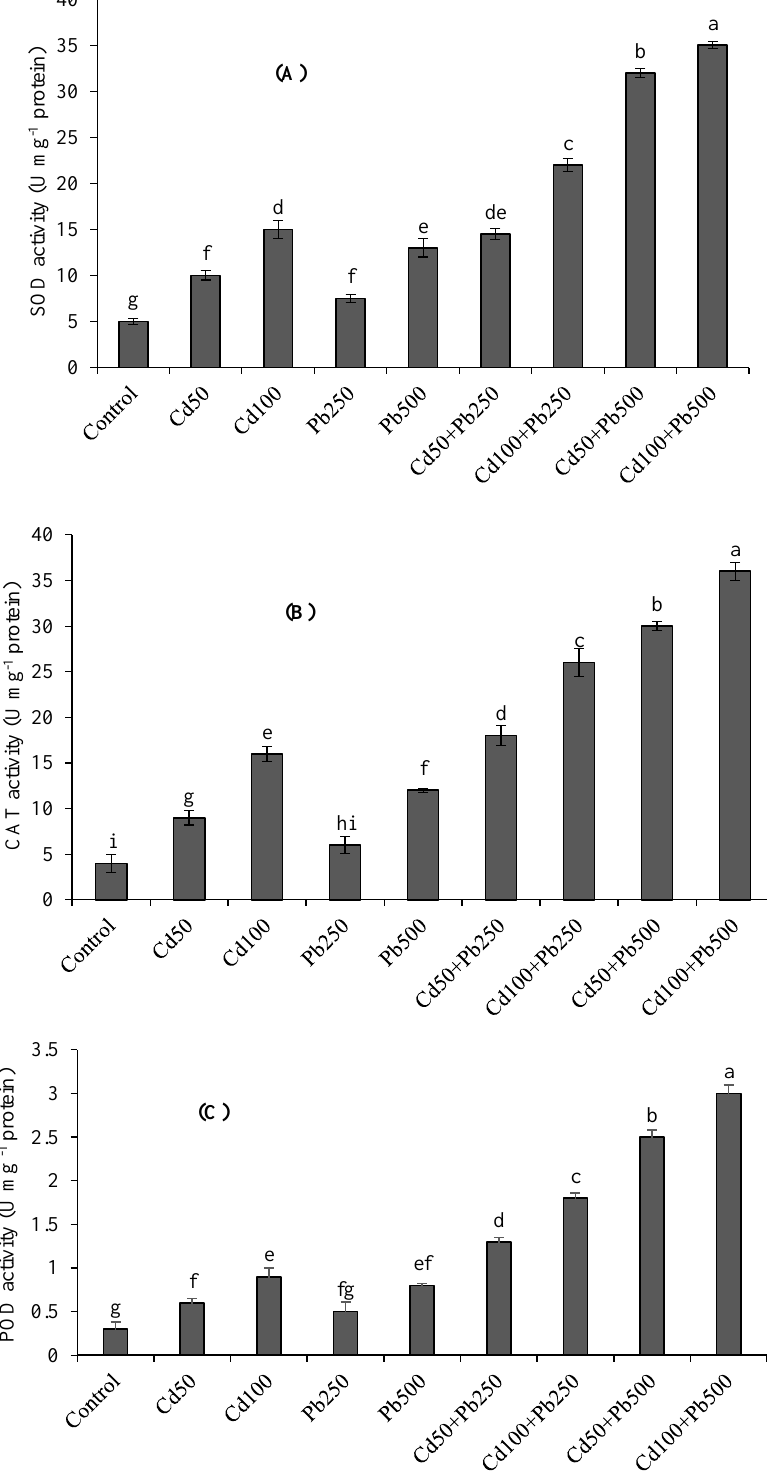
Figure 2. Effect of different levels of Cd, Pb and their combinations on the activities of SOD ( A ), CAT ( B ) and POD ( C ) of quinoa. Different letters represent the significant difference among the treatments at a 5% significance level.